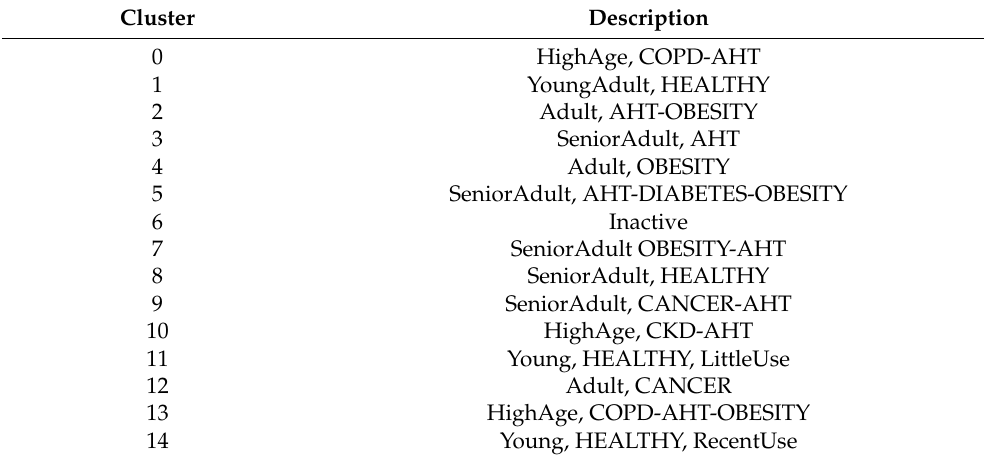
Table 5. Cluster manual description.